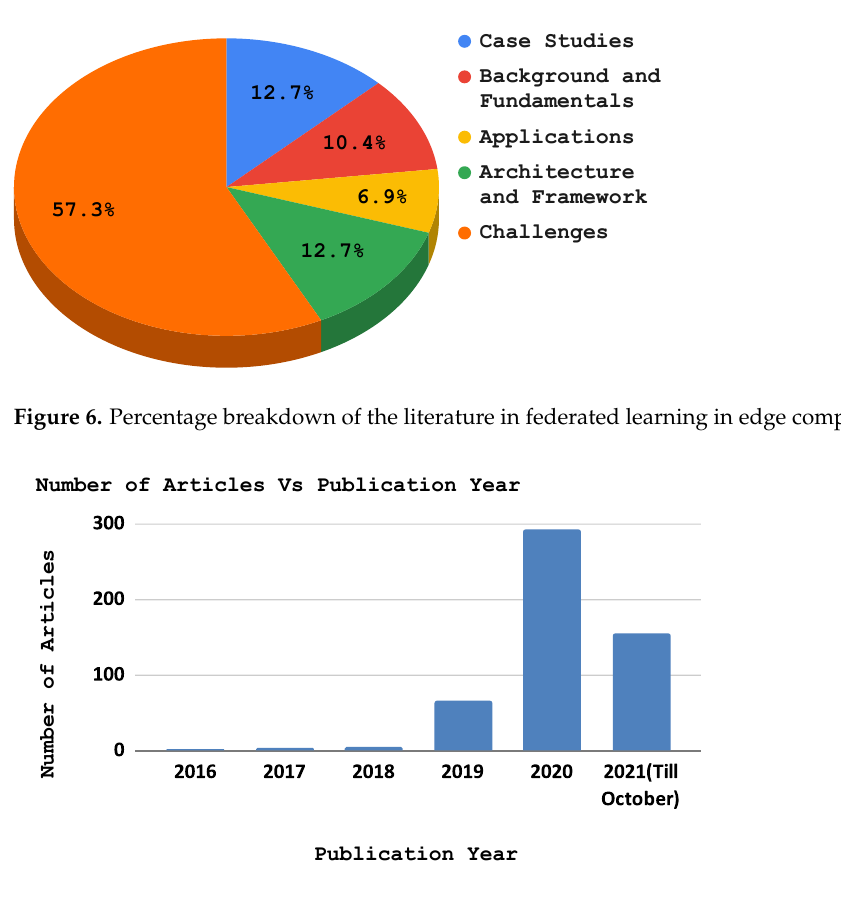
Figure 7. Total number of articles on federated learning in edge computing vs. publication year.